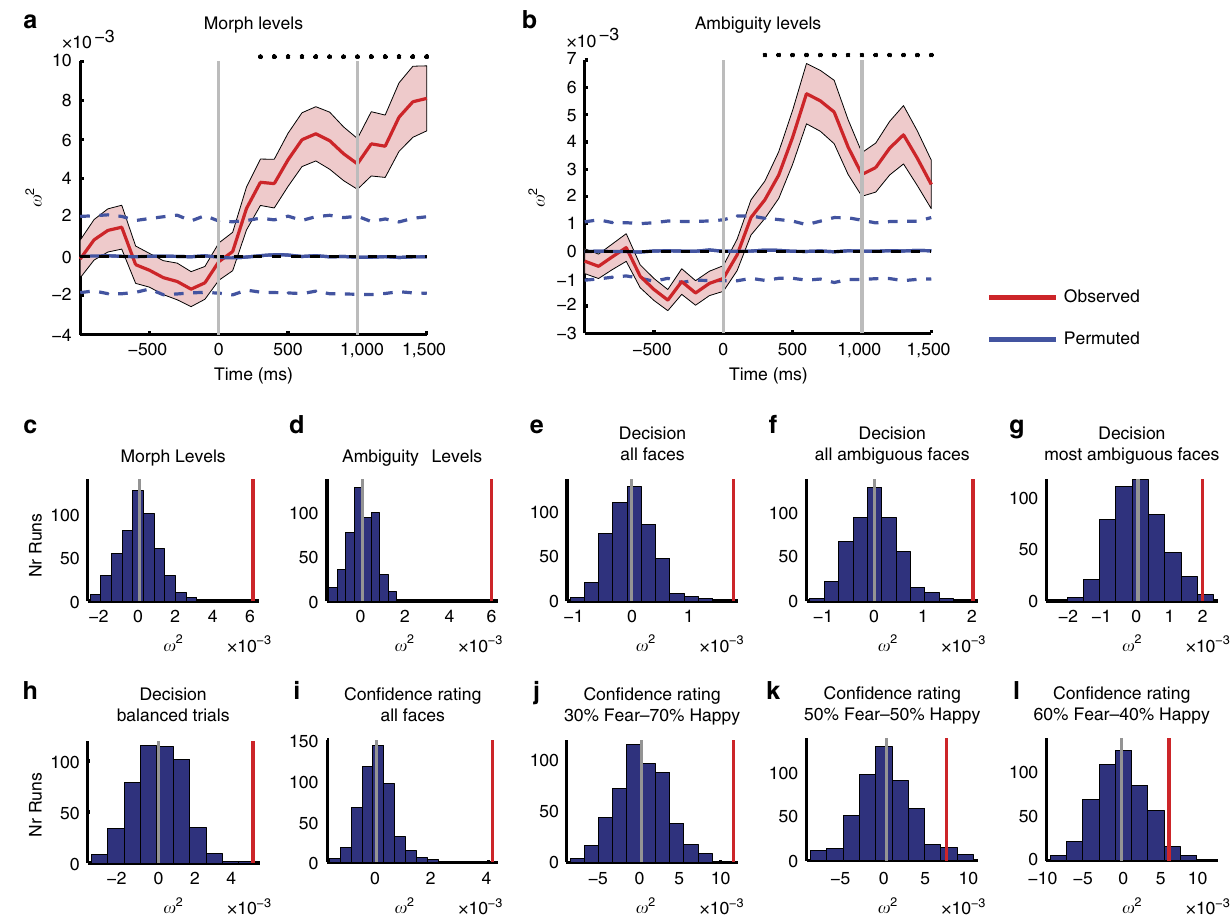
Figure 5 | Population analysis of all recorded neurons ( n ¼ 234) using a regression model and effect size metric x 2 . ( a , b ) Time course of the effect size averaged across all neurons. ( a ) Morph levels. ( b ) Ambiguity levels. Trials are aligned to face stimulus onset (left grey bar, fixed 1s duration). Bin size is 500ms and step size is 100ms. Neurons from permutation were averaged across 500 runs. Shaded area denotes ± s.e.m. across neurons. Dashed horizontal lines indicate the 95% confidence interval estimated from the permuted distribution. Asterisk indicates a significant difference between the observed average across neurons versus permuted average across neurons in that bin (permutation P o 0.05, Bonferroni-corrected). ( c – l ) Summary of the effect size across all runs. Effect size was computed in a 1.5-s window starting 250ms after stimulus onset (single fixed window, not a moving window) and was averaged across all neurons for each run. Grey and red vertical lines indicate the chance mean effect size and the observed effect size, respectively. The observed effect size was well above 0, whereas the mean effect size in the permutation test was near 0. ( c ) Regression model for morph levels (permutation P o 0.001). ( d ) Regression model for ambiguity levels ( P o 0.001). ( e – g ) Regression model for decision of emotion (fear or happy) with ( e ) all faces ( P o 0.001), ( f ) all ambiguous faces (all morphed faces; P o 0.001), ( g ) the most ambiguous faces (40–60% morph; P ¼ 0.006) and ( h )